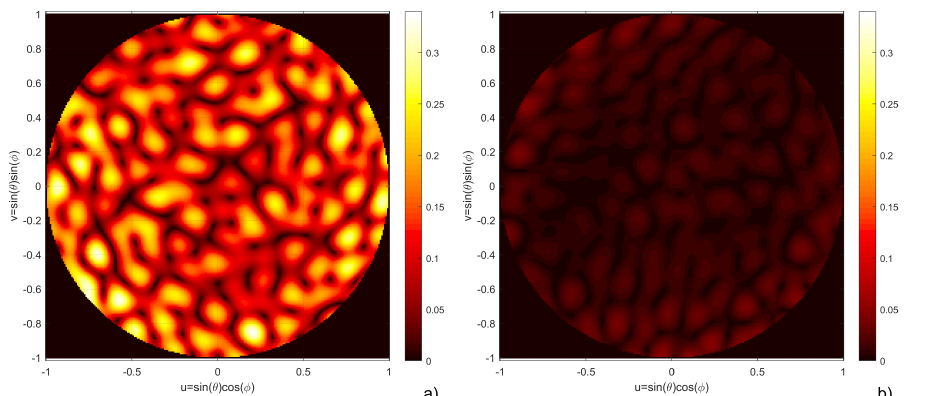
Figure 6. Reconstruction error with respect to the “true” field considering the two algorithms. Subplot ( a ) “standard” algorithm; subplot ( b ): “smooth”